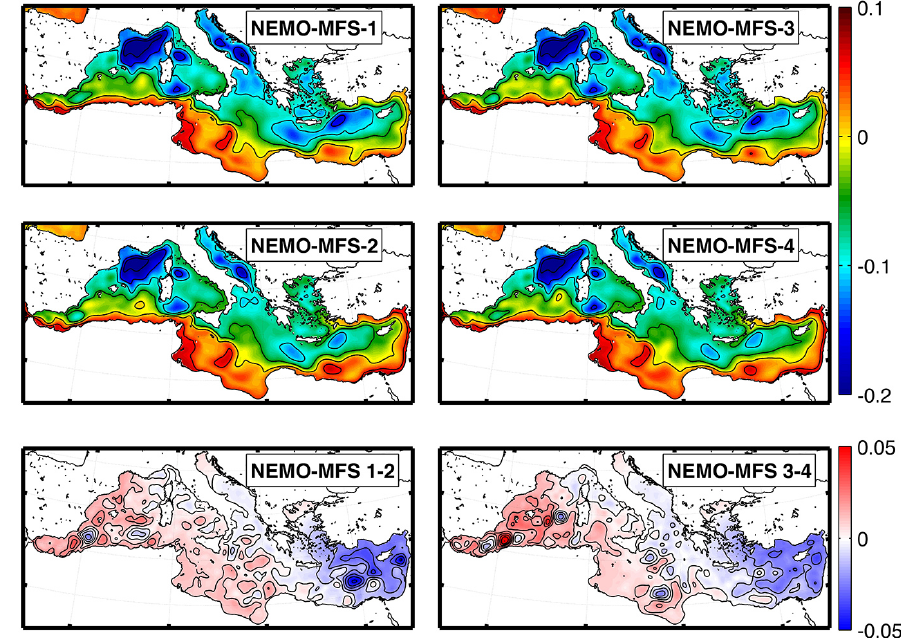
Figure 2. Horizontal maps of the 2-year mean component of the sea surface elevation in the four experiments (units are metres). The two bottom panels represent the sea surface elevation differences between the experiments with and without atmospheric pressure forcing for the time-splitting (right) and the filtered free surface (left)